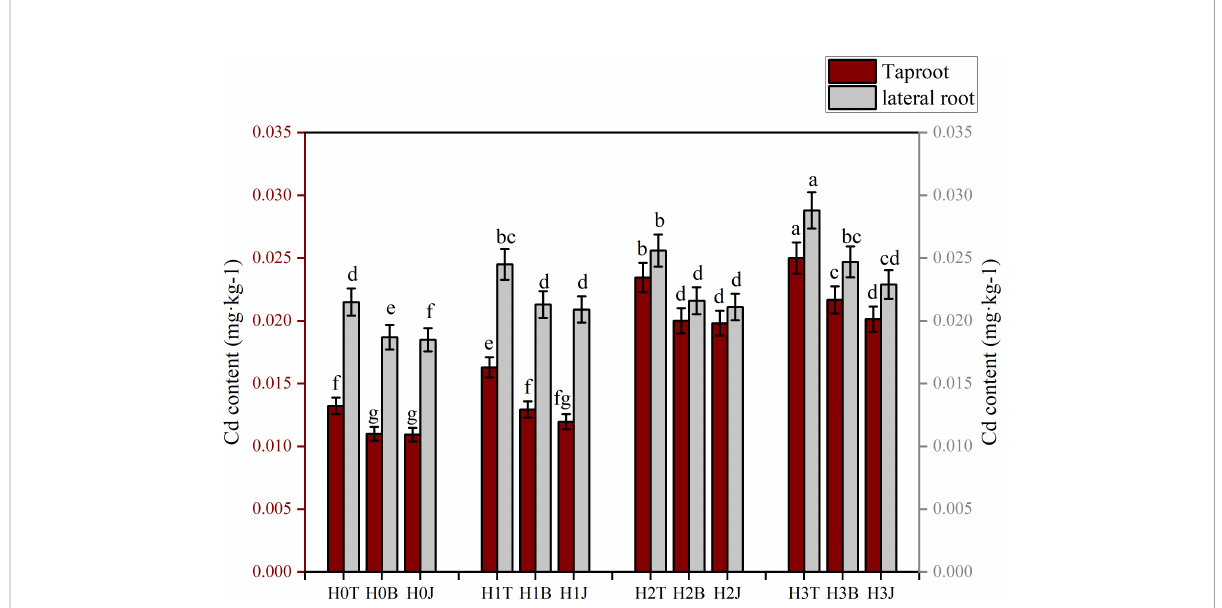
FIGURE 4 Effect of biochar and biofertilizer applications on cotton root Cd content. T, no modi fi ers; B, 3% biochar was applied; J, 1.5 % biofertilizer was applied; H0, no Cd; H1, 1 mg·kg-1 of Cd was applied; H2, 2 mg·kg-1 of Cd was applied; H3, 4 mg·kg-1 of Cd was applied. Values are means ± SE (n=5). Different lowercase letters indicate signi fi cant differences at P < 0.05 (the Duncan